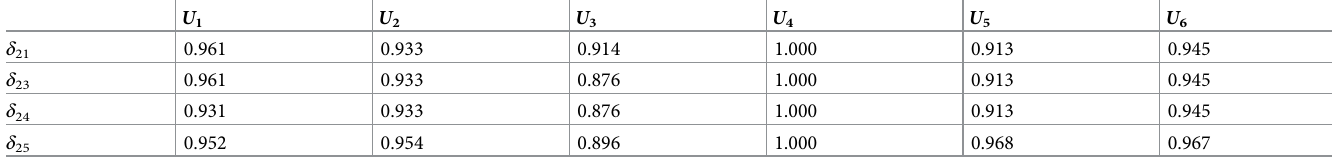
Table 15. The relative weight of O 2 to others.